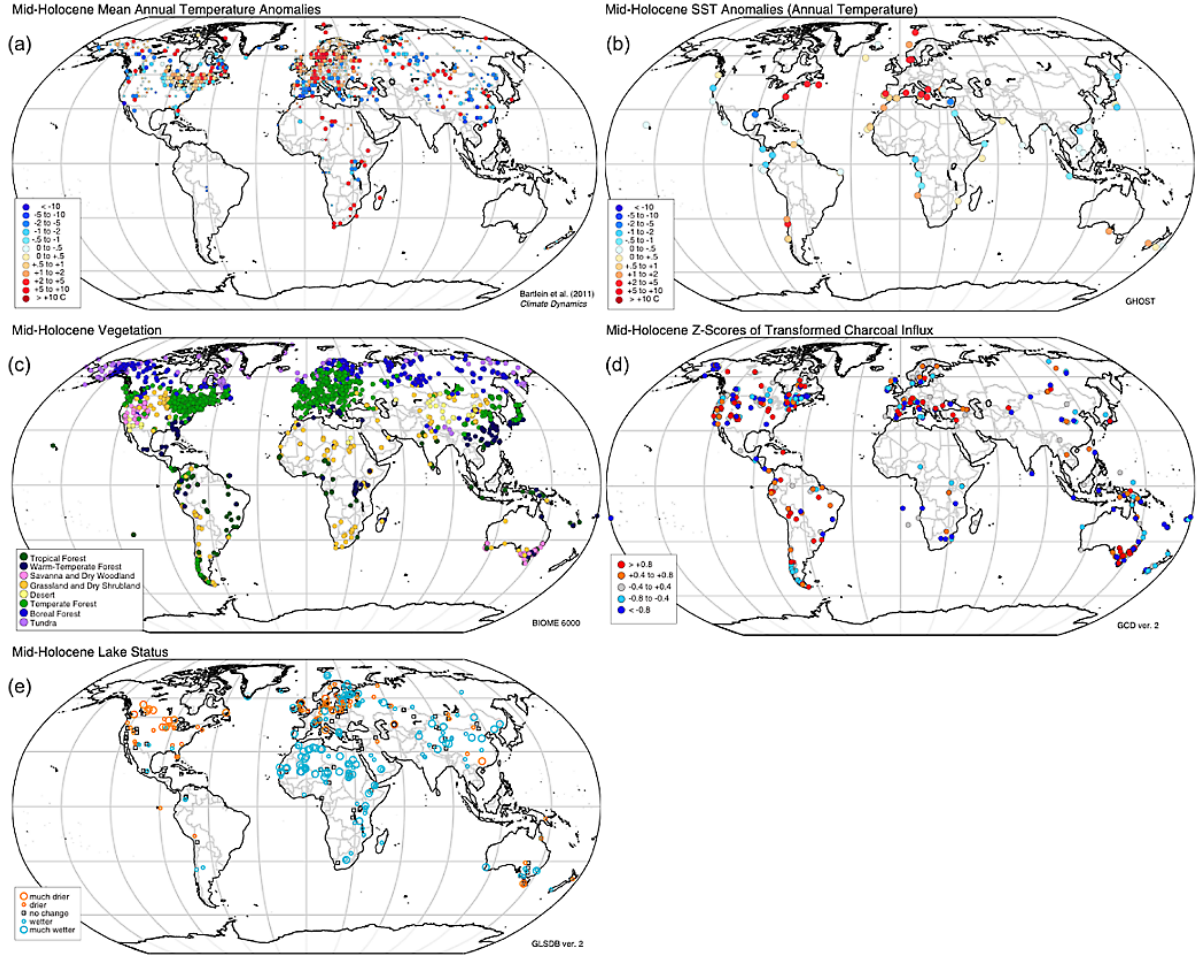
Fig. 3. Examples of global data sets documenting environmental conditions during the mid-Holocene (ca. 6000yr ago) that can be used for benchmarking ESM simulations. In general, these are expressed as anomalies, i.e. the difference between the mid-Holocene and mod- ern conditions: (a) pollen-based reconstructions of anomalies in mean annual temperature, (b) reconstructions of anomalies in sea-surface temperatures based on marine biological and chemical records, (c) pollen and plant macrofossil reconstructions of vegetation during the mid-Holocene, (d) charcoal records of the anomalies in biomass burning, and (e) anomalies of changes in the hydrological cycle based on lake-level records of the balance between precipitation and evaporation (after Harrison and Bartlein, 2012). (Reprinted from Harrison, S. P. and Bartlein, P.: Records from the Past, Lessons for the Future, in: The Future of the World’s Climate, edited by: A. Henderson-Sellars and K. J. McGuffie, 403–436, Copyright © 2012, with permission from